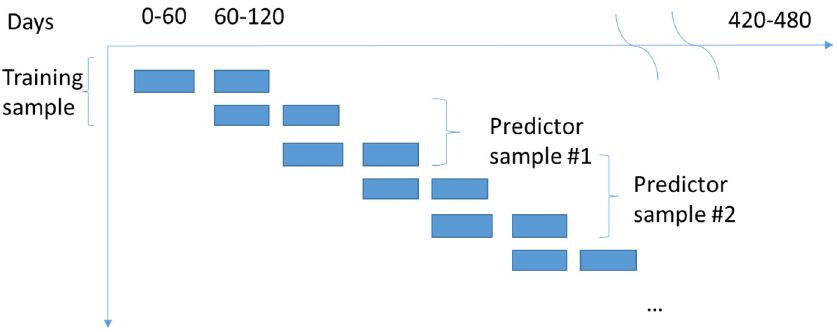
Figure 8. Schematic description of the testing procedure. We use the data on λ , which we consider a measure of market friction, from the training sample to predict indexes from λ ’s in five other samples. In the drawing above, the training sample comes first in calendar time but its position within the entire sample can be arbitrary.